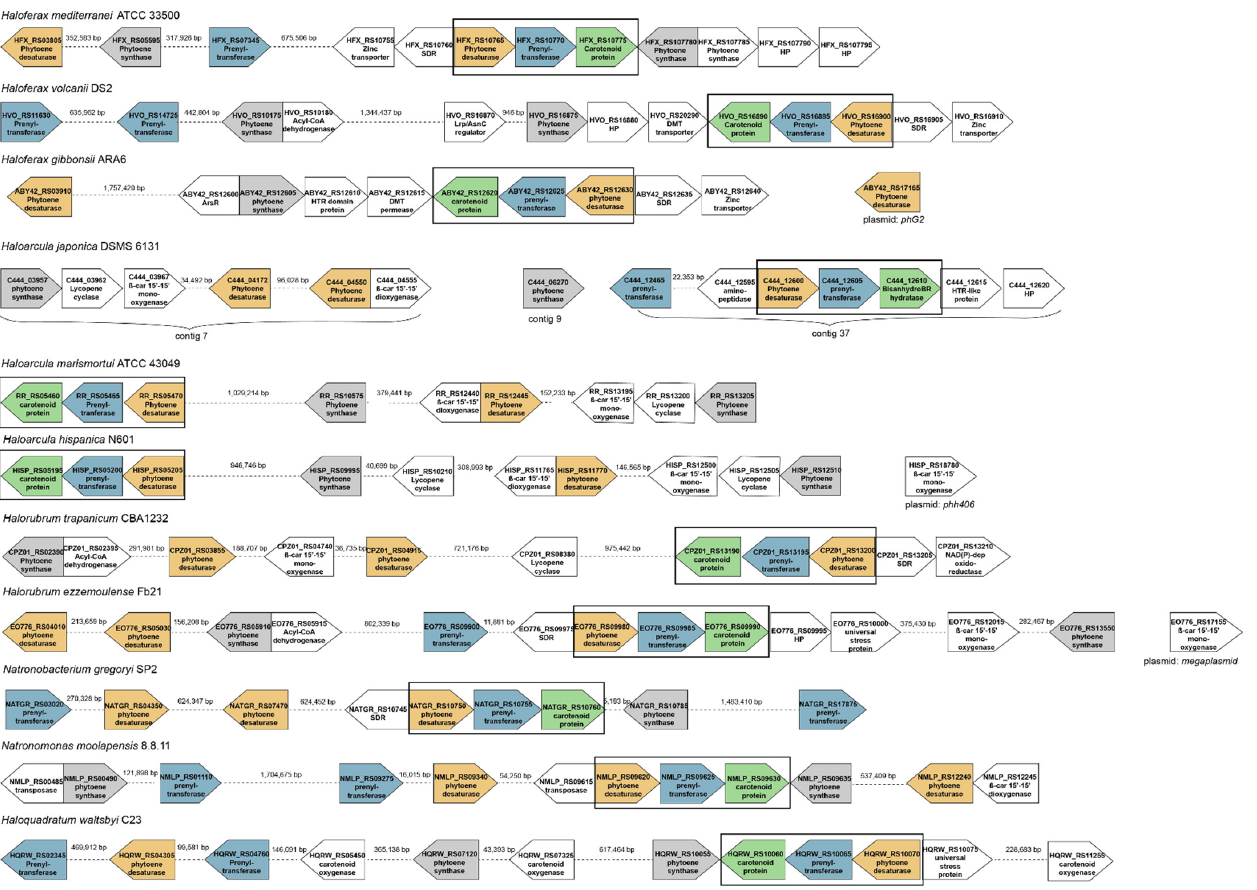
Figure 3. Organization of the genome around the genes involved in carotenogenesis in selected haloarchaeal species. Colors have been used to highlight those genes well conserved between species. Green color represents the gene coding for carotenoid-like protein; blue color represents the gene coding for prenyltransferase; grey color highlights the gene encoding phytoene synthase, and yellow color represents the gene coding phytoene desaturase. The main conserved gene cluster is framed in black.